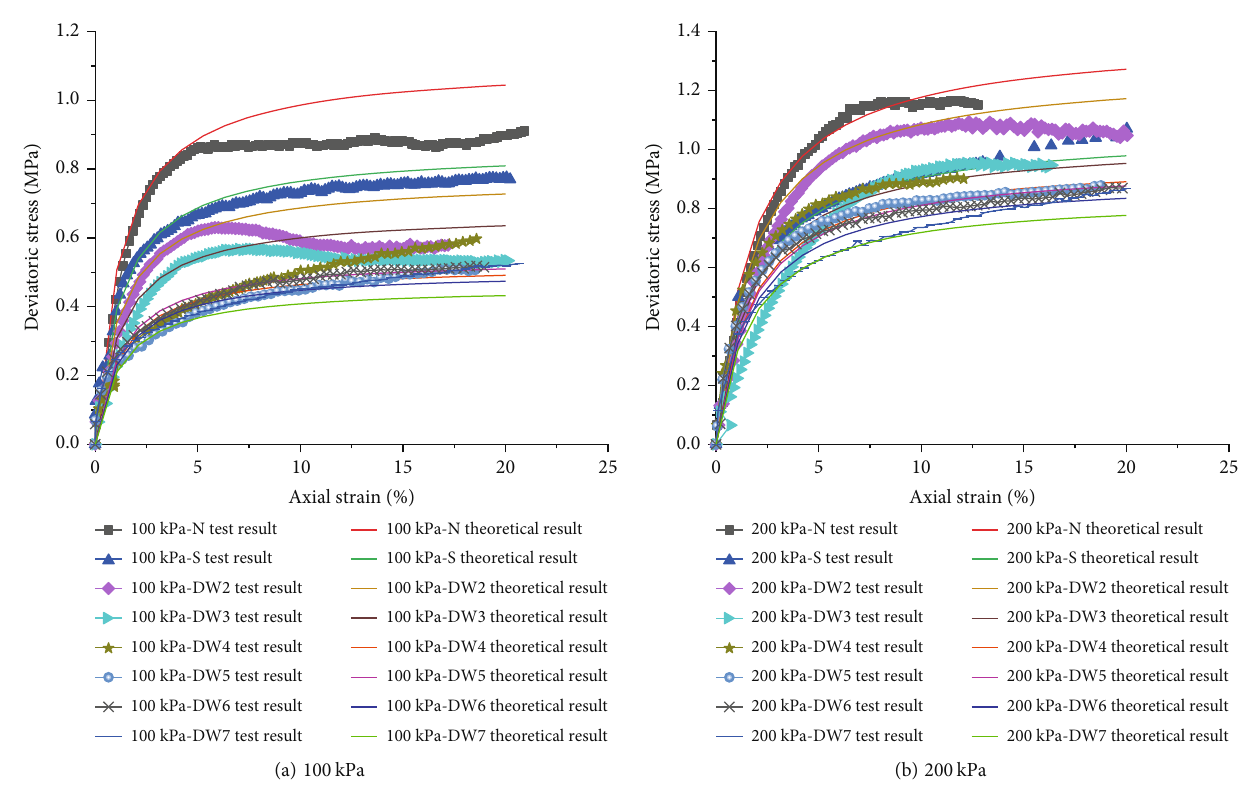
Figure 13: Contrast between the test results and the theoretical results for two di ff erent con fi ning